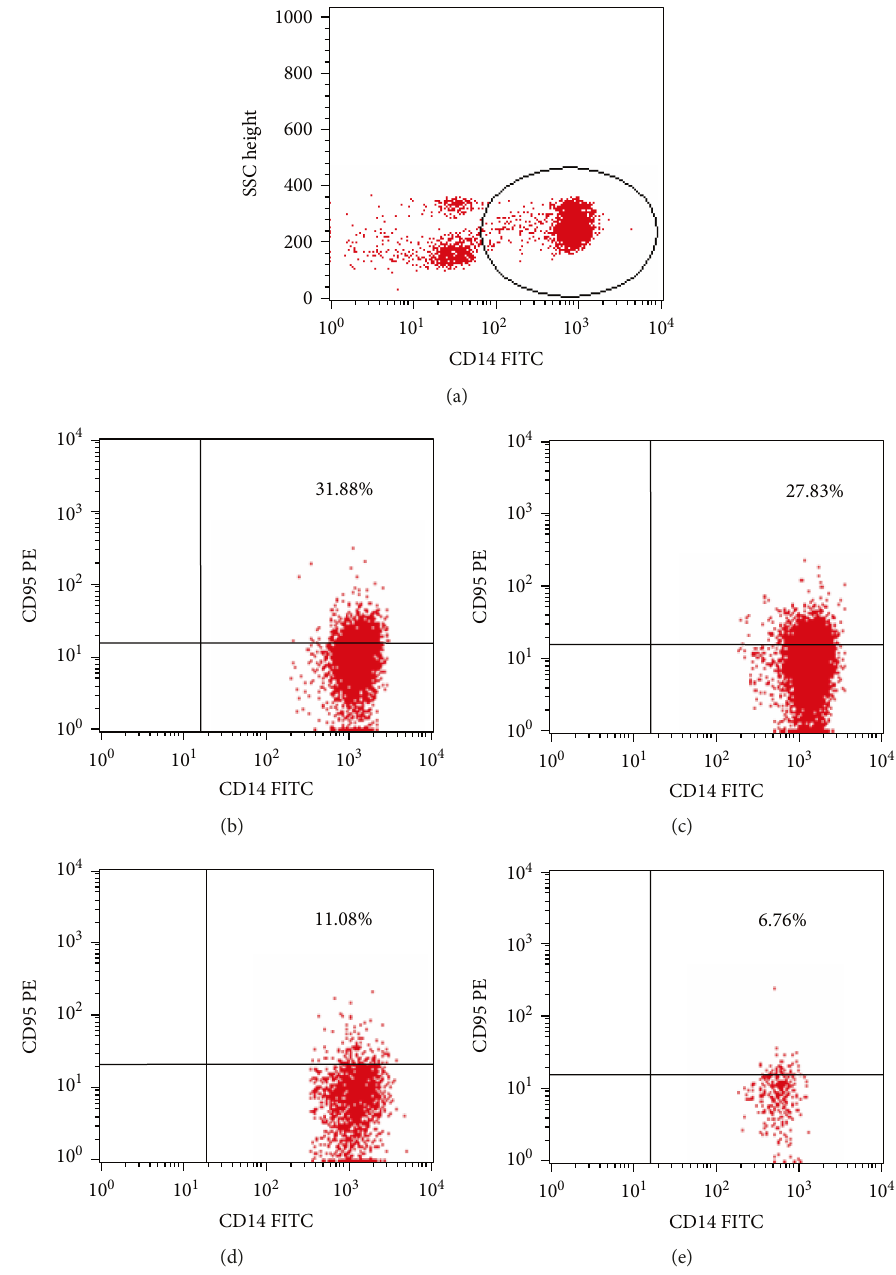
Figure 1: Representative dot plots, illustrating our analysis method for the identi fi cation of CD14 + cells with CD95 (Fas) expression. (a) An acquisition gate was drawn around the CD14 + cells. (b – e) Next, the gated events were analyzed for CD95 PE. The dot plots (b – d) show representative types of CD95 expression in CD14 + cells from patients with endometriosis. The dot plot (d) shows the representative type of CD14 + CD95 + cells from the reference